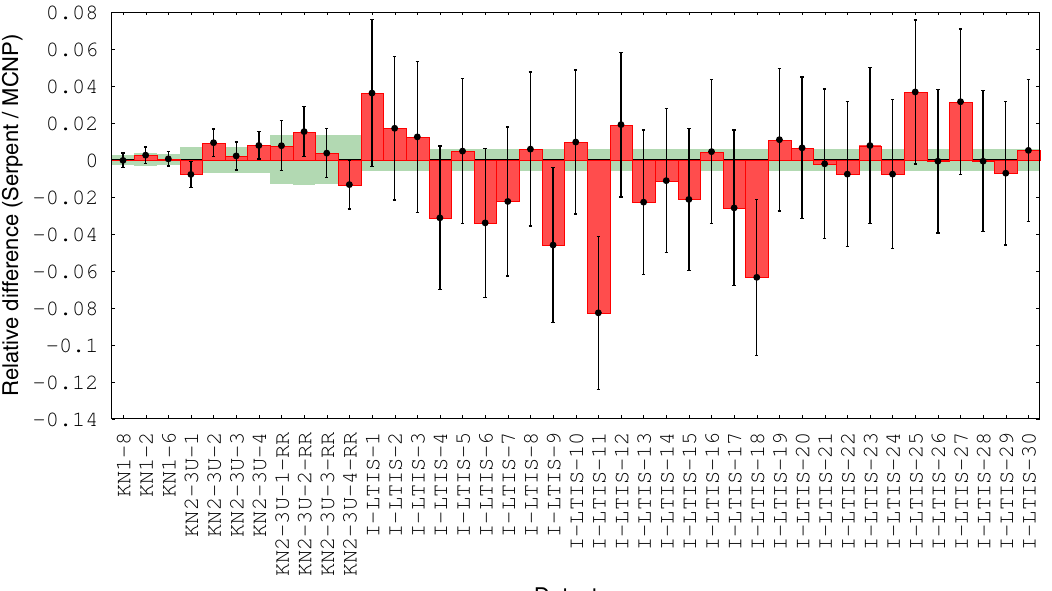
Figure 3: Relative difference of neutron fluxes between Serpent and MCNP for all detector positions and reaction rates in a DD plasma. The 1 σ uncertainty of MCNP is presented with the green bars while the 1 σ uncertainty of Serpent is presented with